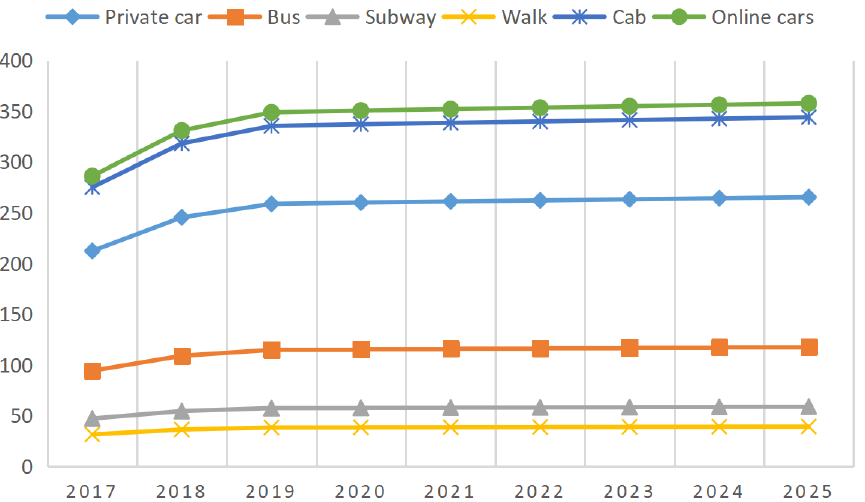
Figure 7. Total alternative distance travelled by the six modes of travel (million meters).